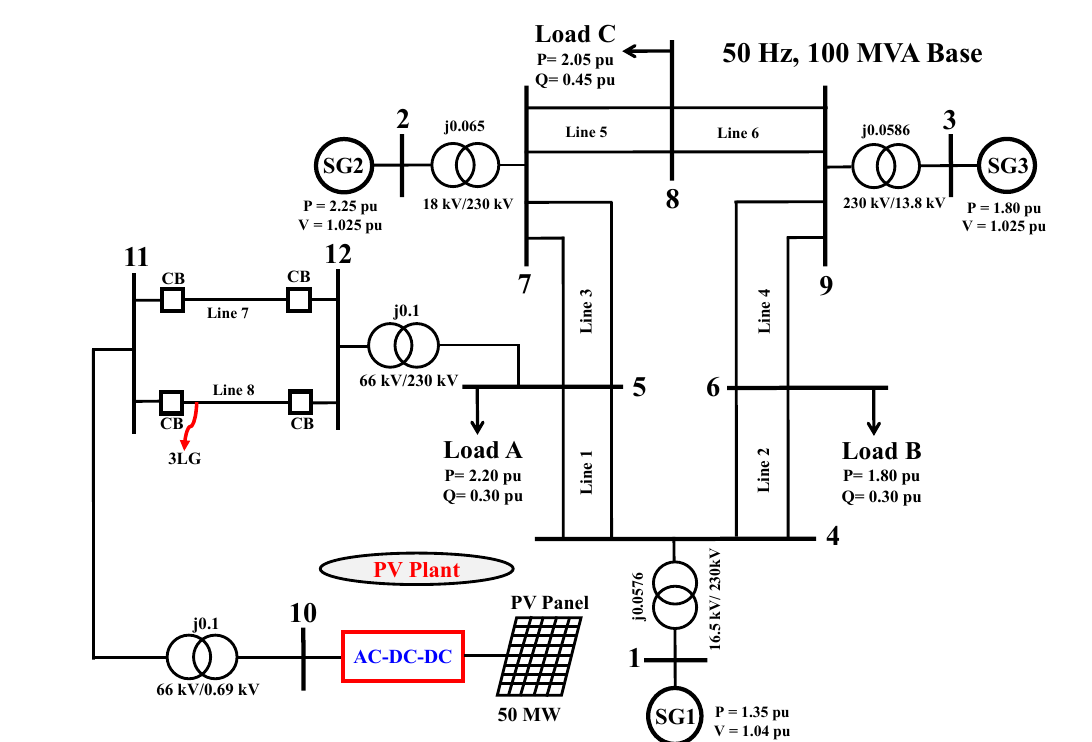
Figure 8. System model of a modified IEEE nine bus power plant model.